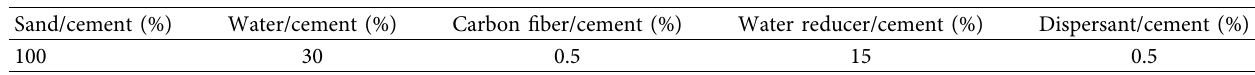
Table 2: Mass ratio of CFRC materials.